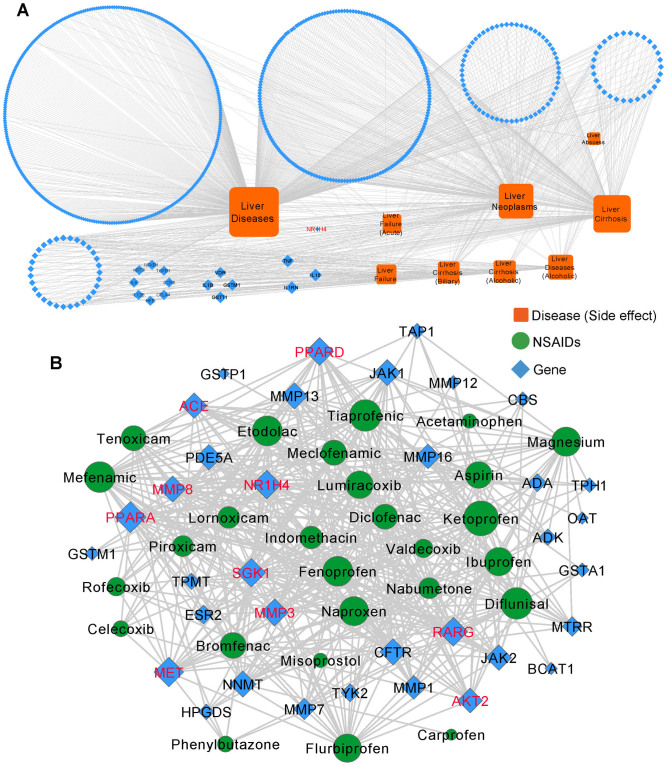
Identifying the NSAID-protein interaction network that is associated with drug-induced liver toxicity using the molecular modeling and network analysis.(A) Liver disease-gene association network, in which 9 liver disease terms (gold squares) and 627 genes (cyan diamonds) were connected if a gene is a known liver disease-associated genes annotated in four public databases. (B) Prediction of new NSAID-protein (off-target) interaction networks, in which a NSAID (green circle) and a protein encoded by the liver-disease associated gene are connected if the docking scores of NSAID-protein complex is higher than the average docking scores. 10 gene symbols labeled by red represent significantly predicted NSAID off-target proteins (P < 0.01). The detailed data are provided in Supplementary Tables S1 and S2.